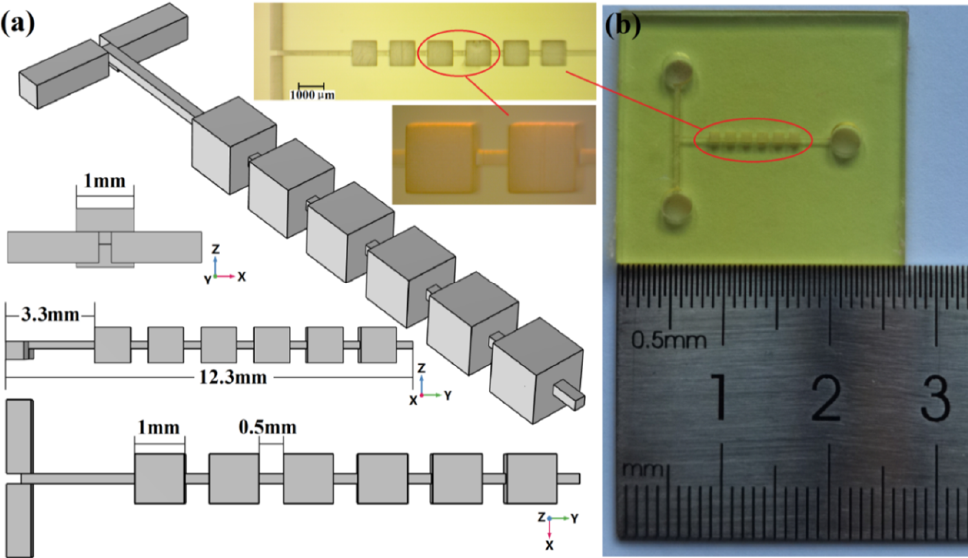
Figure 1. The micromixer with initial repetitive structure. ( a ) The schematics of the mixer; ( b ) photograph of the mixer.